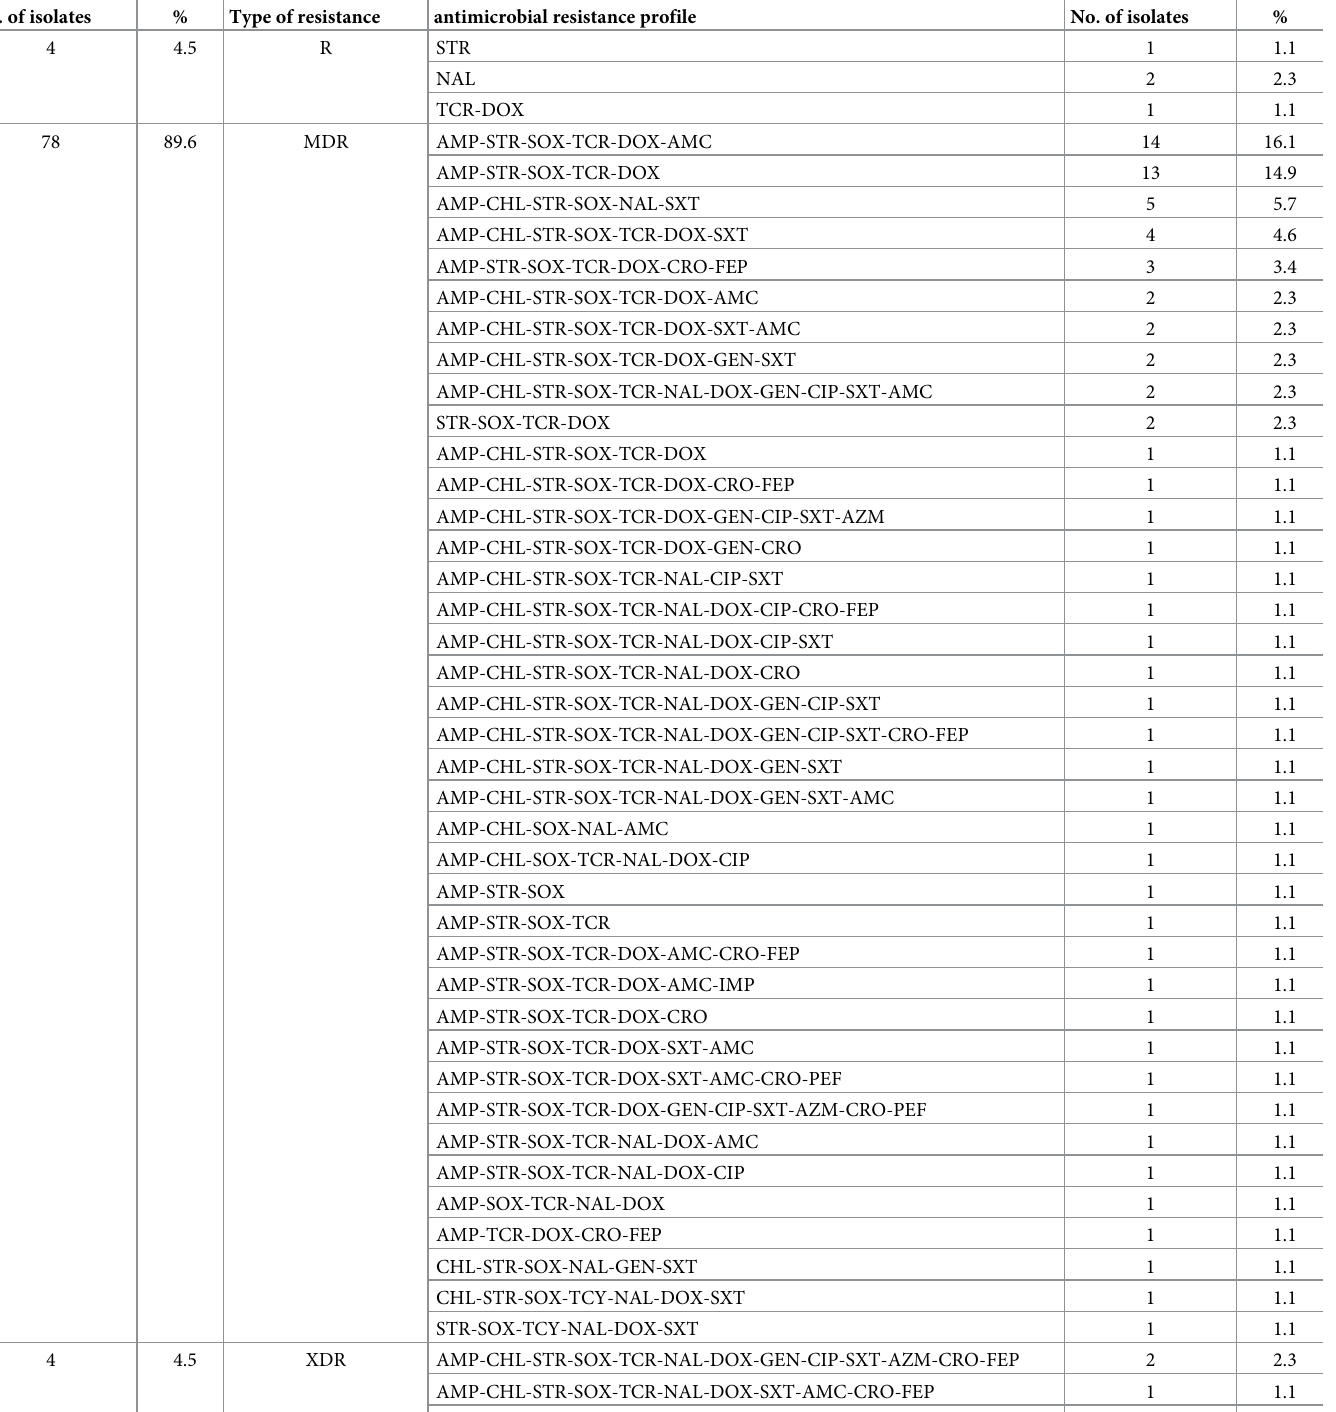
Table 2. Antimicrobial resistance profile of Salmonella 4,[5],12:i:- isolates. No. of